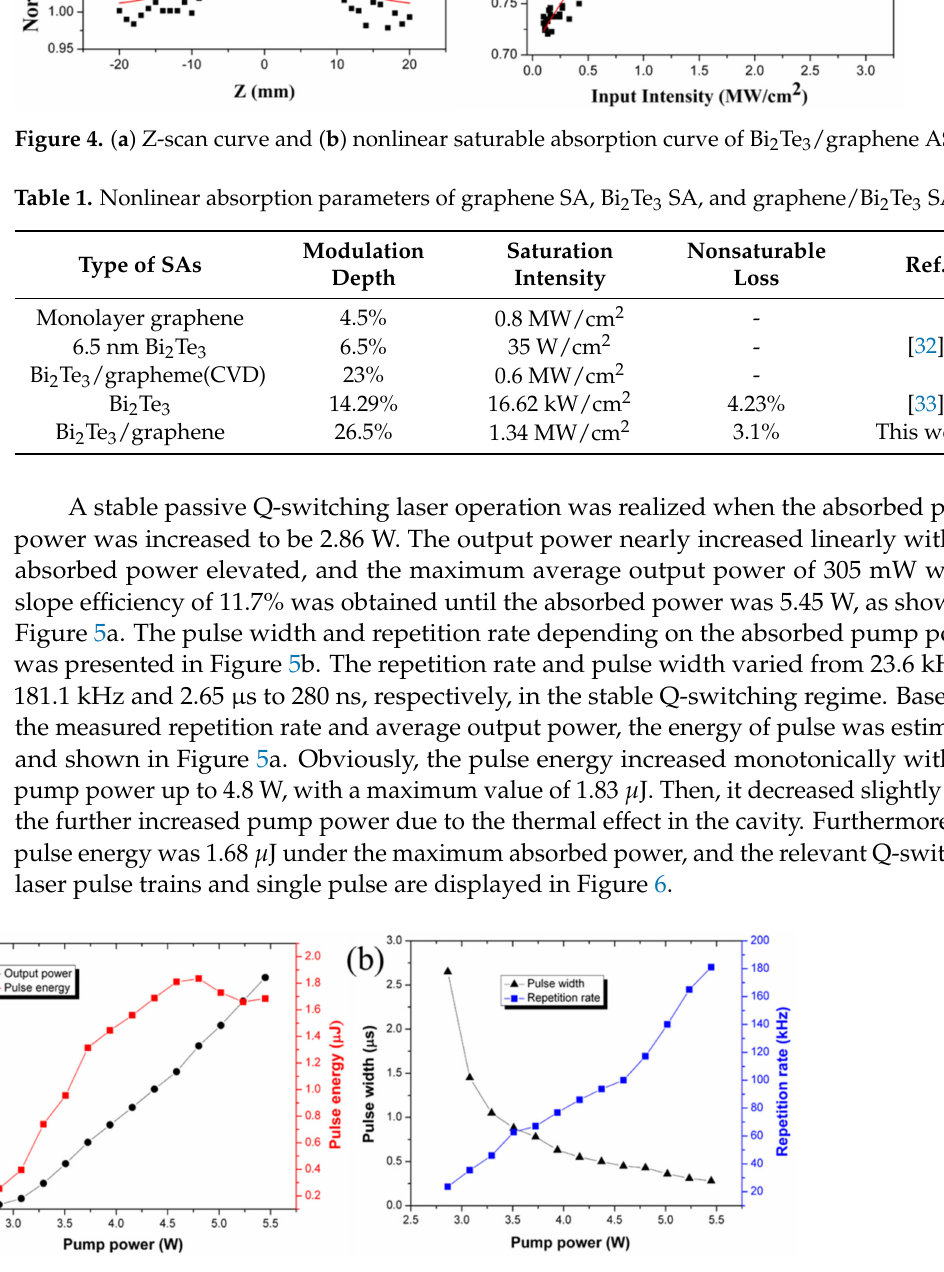
Figure 5. ( a ) The output power and single-pulse energy; ( b ) pulse width and repetition rate over the absorbed pump